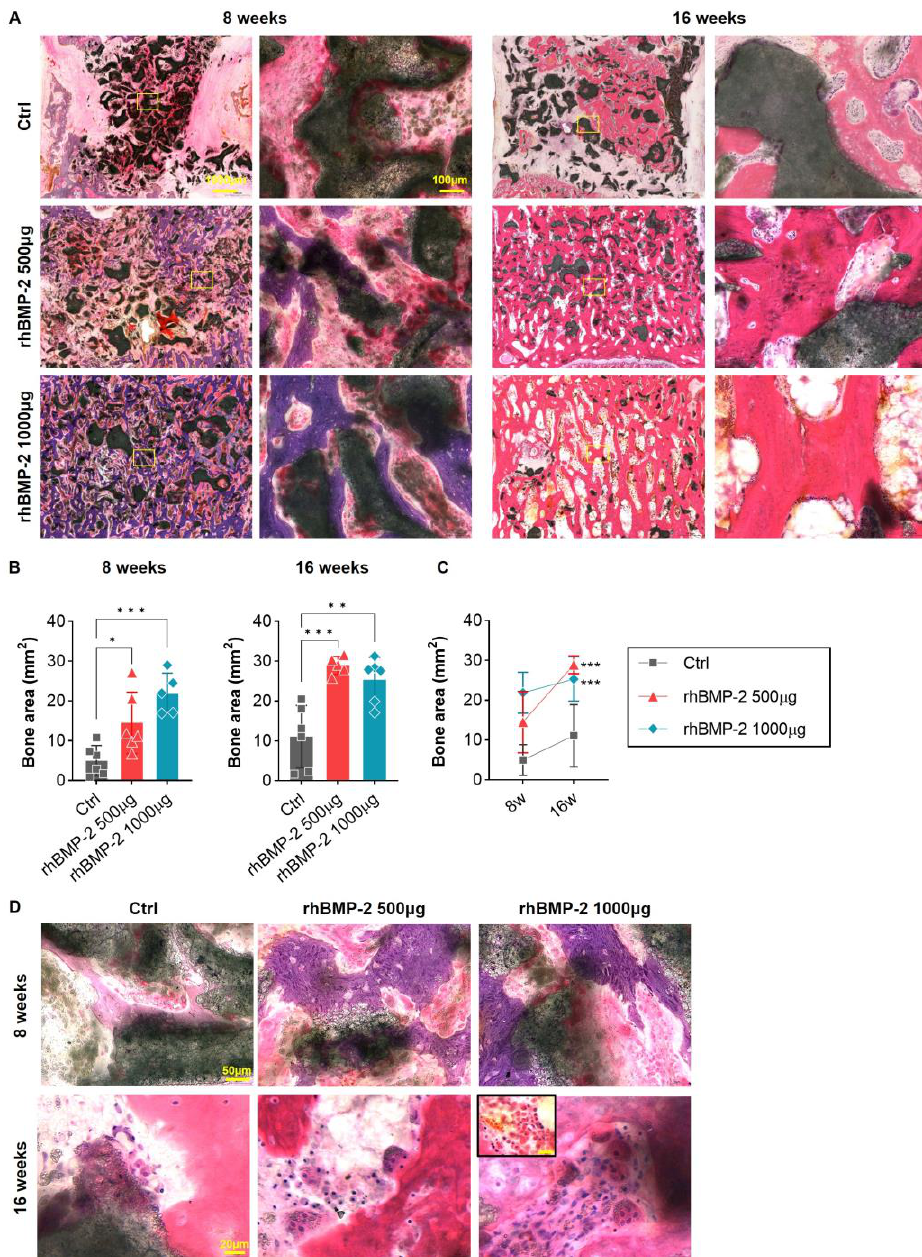
Figure 4. H&E staining to confirm the bone region and inflammatory reaction. ( A ) Overall and magnified pictures after hematoxylin and eosin (H&E) staining inside the cage of the fusion area. ( B , C ) Graphs analyzing the bone area (stained purple and pink). The bone area increased in proportion to the concentration of rhBMP-2 in the 8-week spine samples, but the low-concentration group (500 μg of rhBMP -2) showed higher values in the 16-week spine sample. ( D ) Magnified image of the fusion region. The BGM carrier was used for the synthesis of the new bone area at 8 weeks. Bone remodeling by osteoclasts was accelerated at 16 w after new bone synthesis was completed and increased in proportion to the concentration of rhBMP-2. Furthermore, inflammatory cells were recruited in the fusion region in the high- concentration group (1000 μg of rhBMP -2). * p < 0.05, ** p < 0.01, and *** p < 0.001 indicate statistically significant differences.